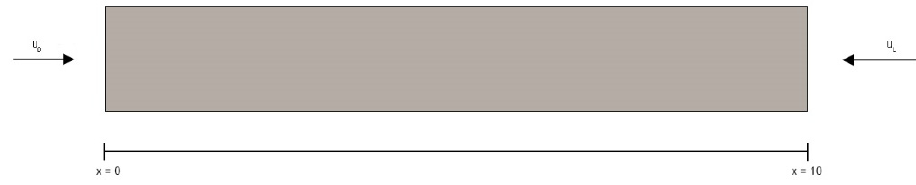
Figure 3. 2D duct model.